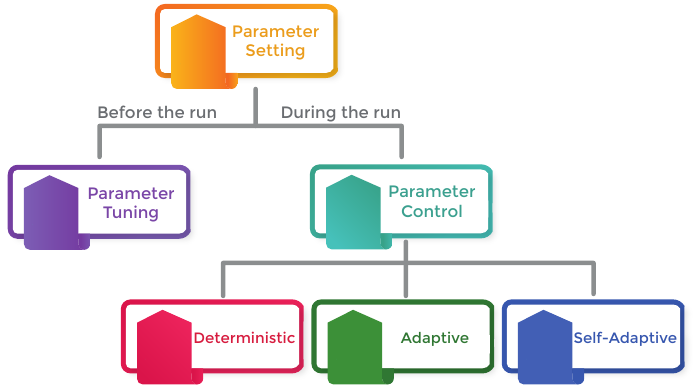
Figure 1. Scheme of the parameter adaptation process in bio-inspired